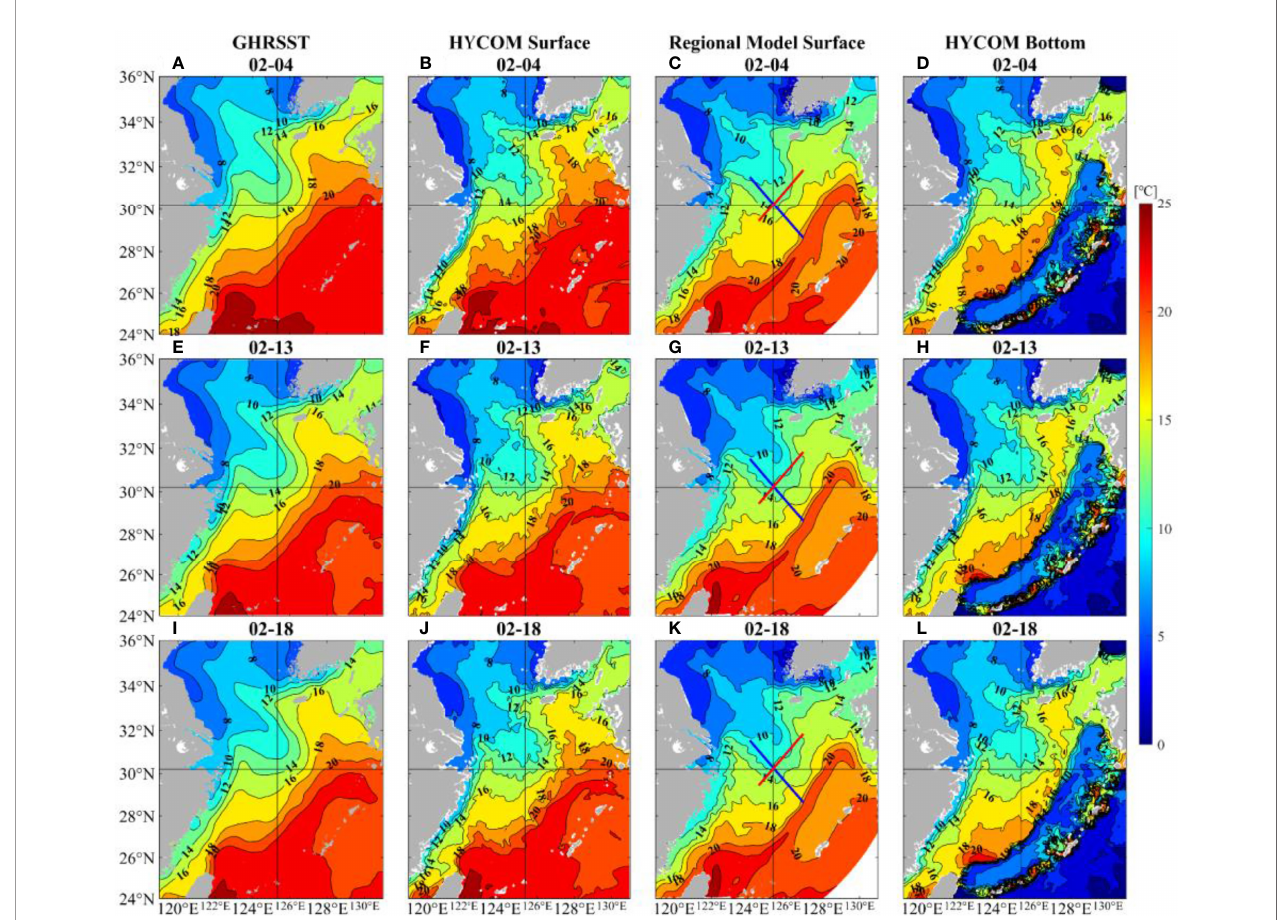
FIGURE 3 | Comparison of sea surface temperature obtained from GHRSST (left panels: A, E, I ), global HYCOM (the second panels: B, F, J ), and the regional model (the third panels: C, G, K ): note that the red line refers to the NE-SW transect and the blue line refers to the NW-SE transect; the bottom temperature obtained from global HYCOM (right panels: D, H, L ). The selected time is 4, 13, and 18 February